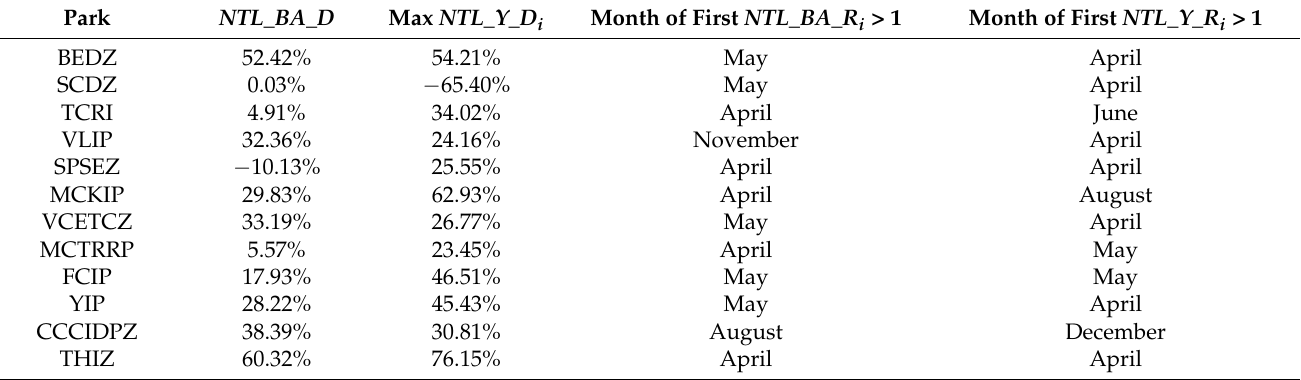
Table 4. AnalysisofCOVID-19impactsontheoperationsofCIPSAs, accordingtothefourratioparameters.